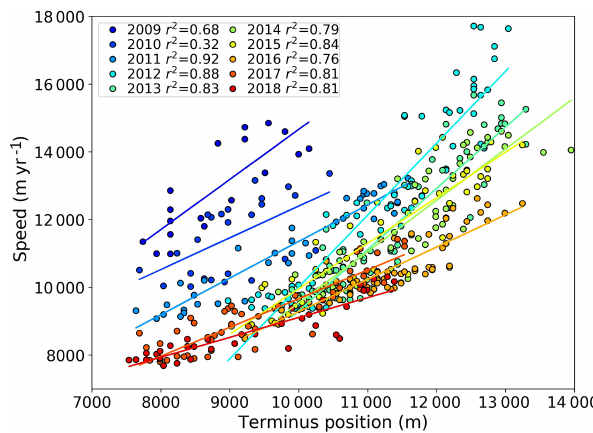
Figure 5. Speed at T max − 1km (see grey points Fig. 1) as a function of terminus position (relative to the profile shown in Fig. 1) for each year from 2009 to 2018, with greater terminus positions indicating greater retreat. Lines show linear regressions for each year with r 2 values included in the